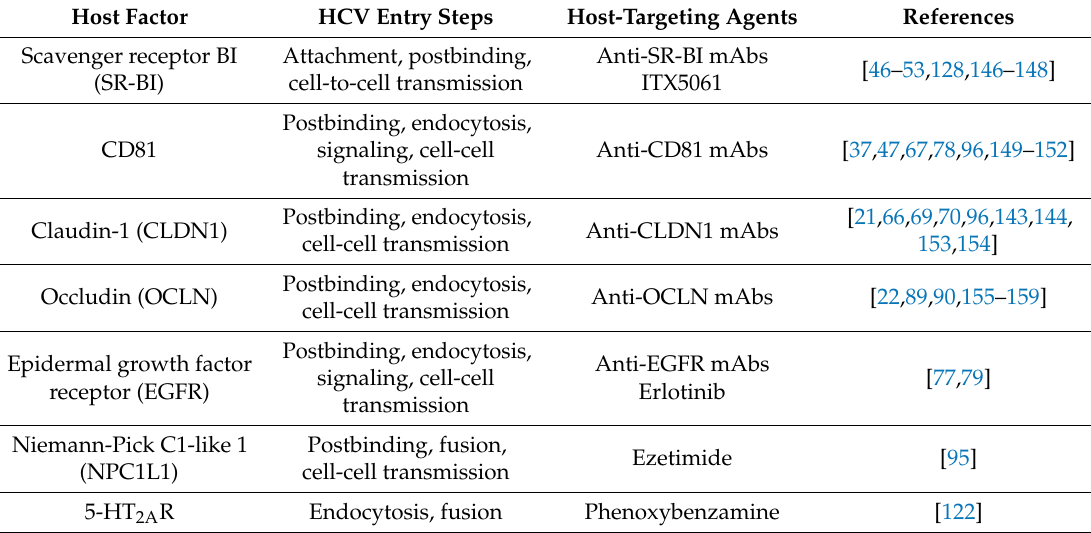
Table 1. Host factors involved in HCV entry that have been suggested as antiviral targets. Only host factors for which host-targeting entry inhibitors, e.g., monoclonal antibodies (mAbs) or small molecule inhibitors have at least reached in vivo preclinical development are listed. A comprehensive list of host factors and their role(s) in HCV entry is provided in